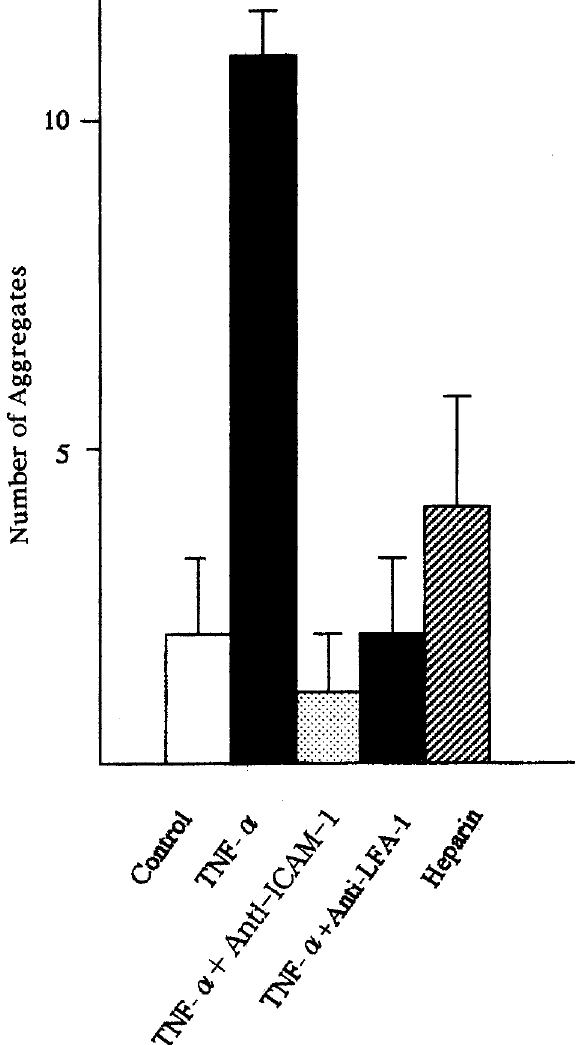
FIG. 5. Effect of TNF- a , TNF- a + Anti-ICAM-1Ab, TNF- a + Anti- LFA-1Ab and heparin on AM aggregation in vitro . Data are presented as the mean ±SEM of the number of cells comprising each